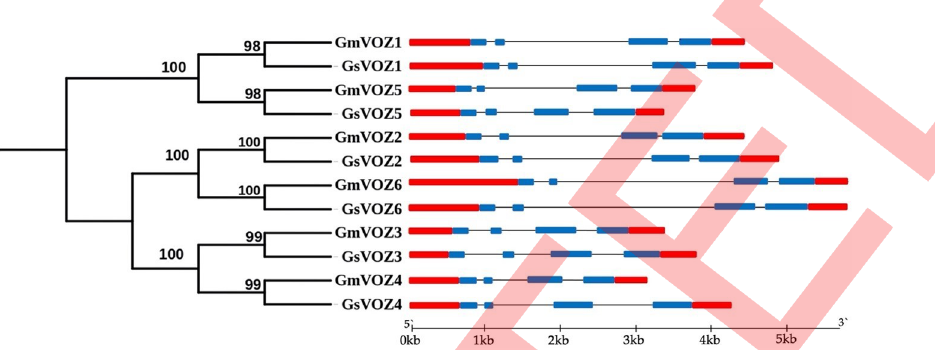
Fig 4. Gene structure display of G . max and G . soja . Red-box represents untranslated and blue-box represents exon regions.